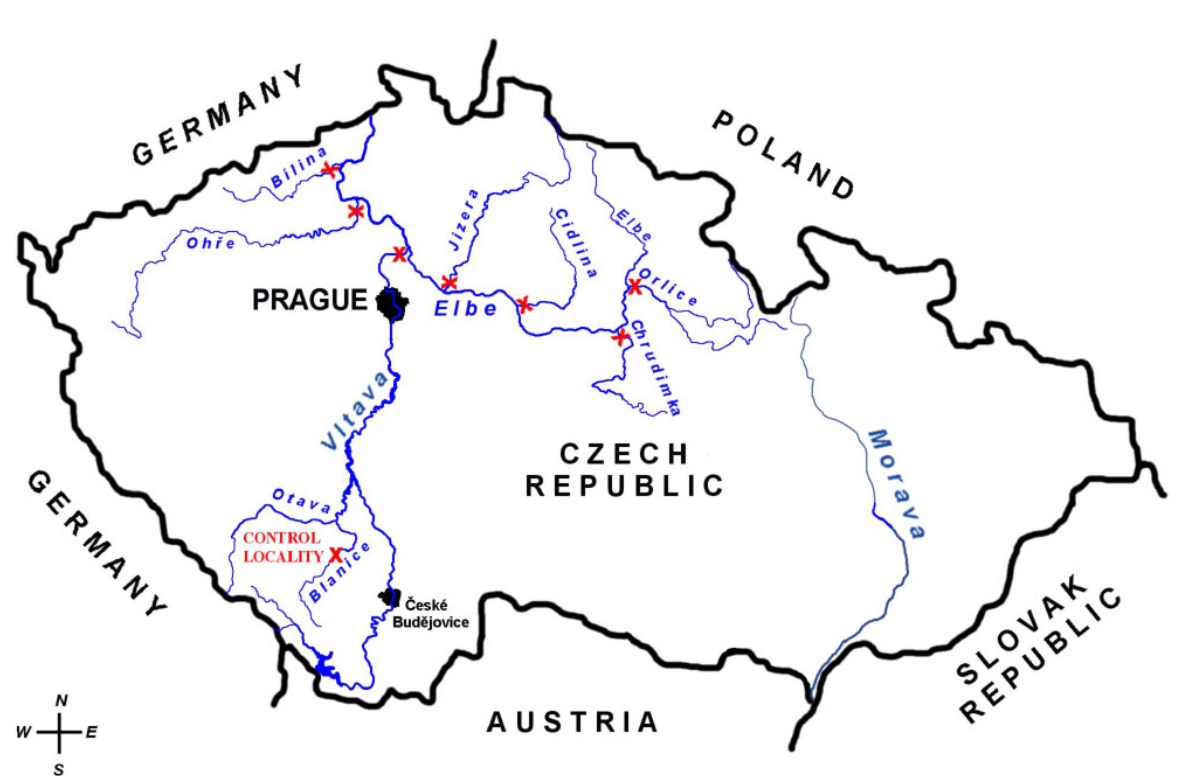
Figure 1. Map of the Czech Republic and location of sampling sites and the control